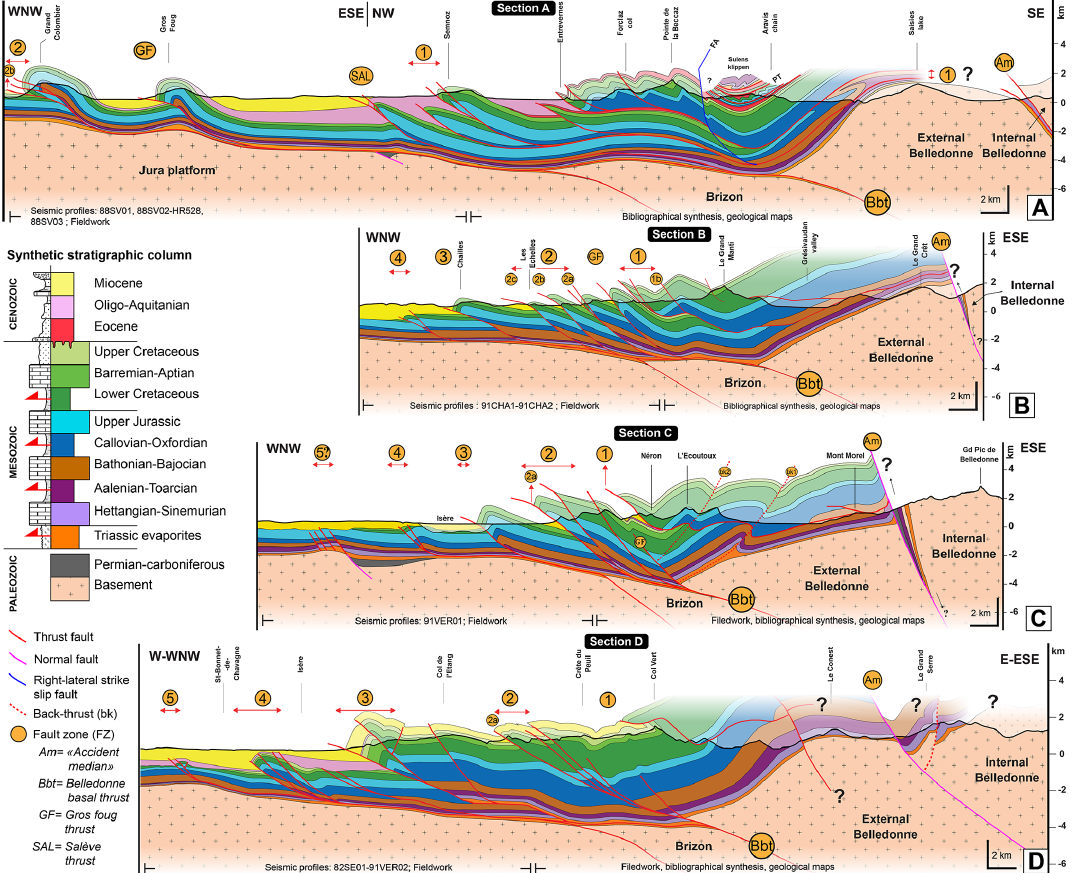
Figure 11. Regional cross sections of the study area. Cross section location in Fig. 1. (A) Cross section A through the eastern Jura and the Bornes. PT: Penninic thrust. AF: Arcalod fault. (B) Cross section B through central Chartreuse and Belledonne. (C) Cross section C through southern Chartreuse and Belledonne. (D) Cross section D through Vercors and southern